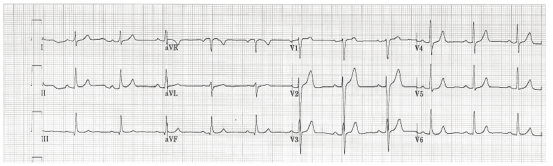
Figure 1: ECG during chest pain.